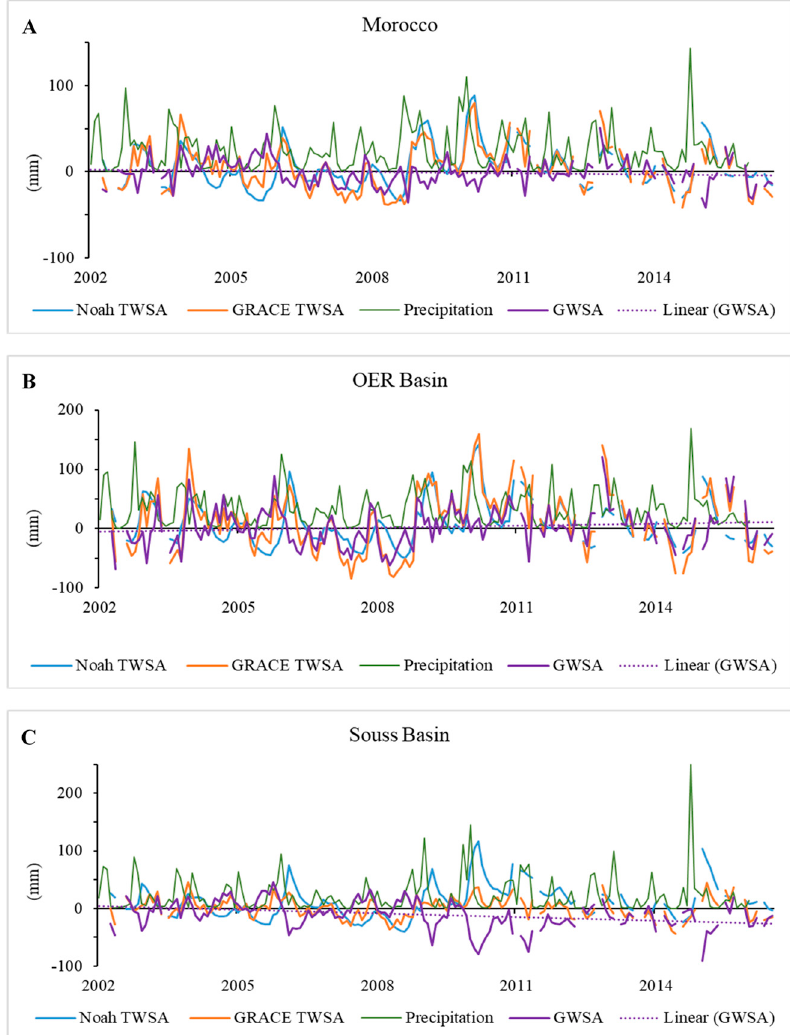
Figure 5. ( A ) Monthly TWS anomaly (orange), GWS anomaly (purple), and precipitation (green) in Morocco; ( B ) Monthly TWS anomaly (orange), GWS anomaly (purple), and precipitation (green) in Oum Er Rbia Basin; ( C ) Monthly TWS anomaly (orange), GWS anomaly (purple), and precipitation (green) in Souss Basin.